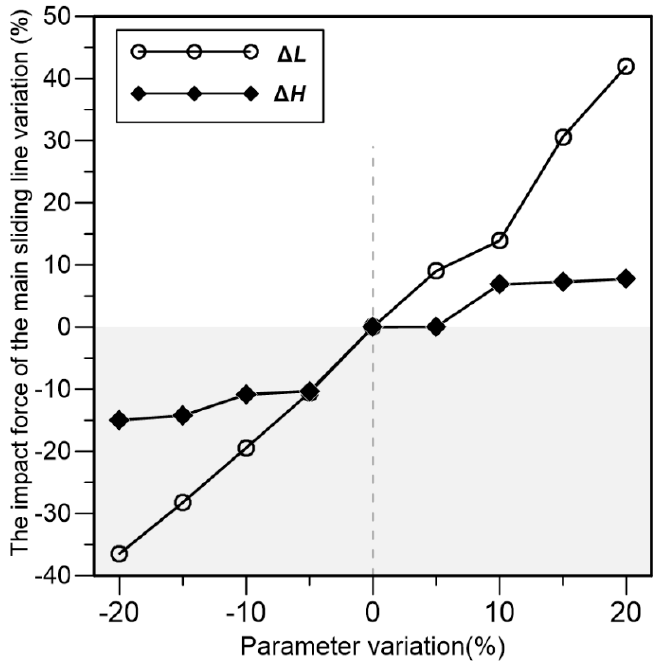
Figure 15. Sensitivity analysis of the proposed method. The resulting variation of impact force along the main sliding direction as a function of the chosen